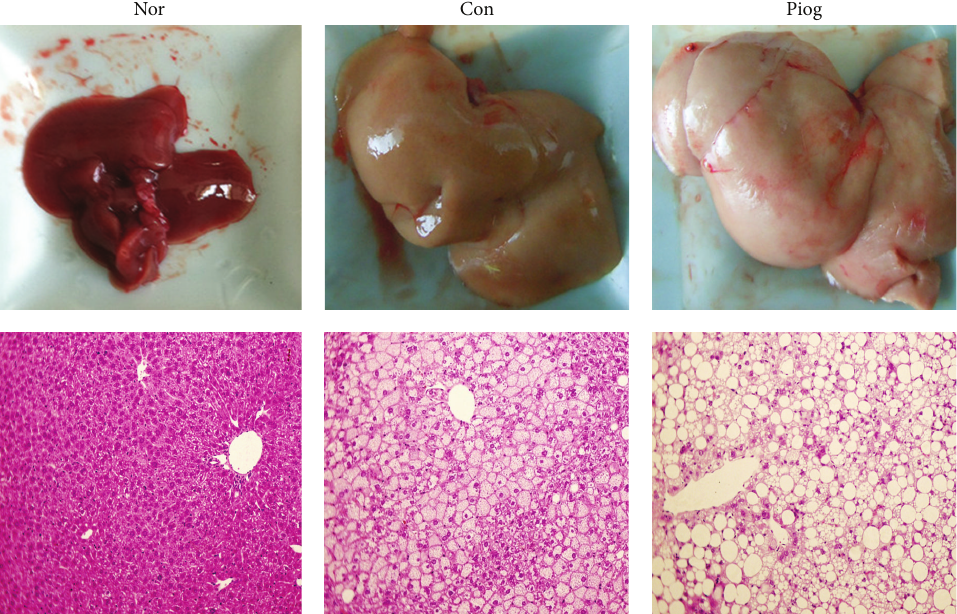
Figure 3: Pioglitazone-induced effects on liver histology of KKAy mice. Representative liver photos and photomicrographs (200 × ) of H&E- stained liver sections from C57BL/6J mice (Nor), vehicle-treated KKAy mice (Con), and pioglitazone-treated KKAy mice